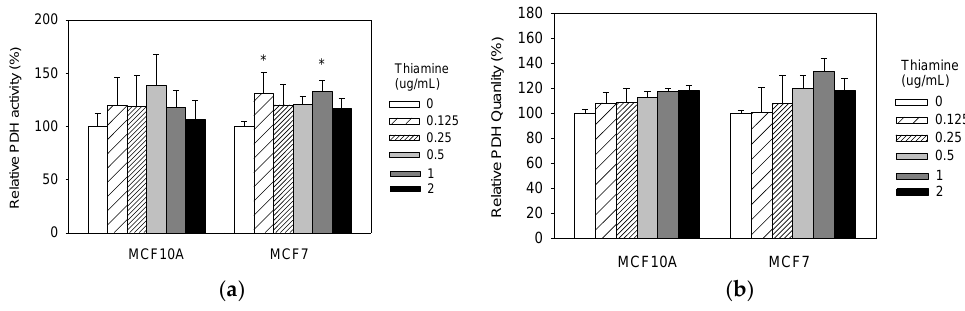
Figure 2. Thiamine increases cellular pyruvate dehydrogenase (PDH) activities in breast cancer cells. Cells were treated with range of doses of thiamine for 24 h, and PDH activity ( a ) and quantity ( b ) were then measured using the PDH combo microplate assay kit (Abcam, Inc., Cambridge, MA, USA). Results are expressed as mean ± SE (* significant difference relative to control (0 μg/mL Thiamine supplementation), white bar).